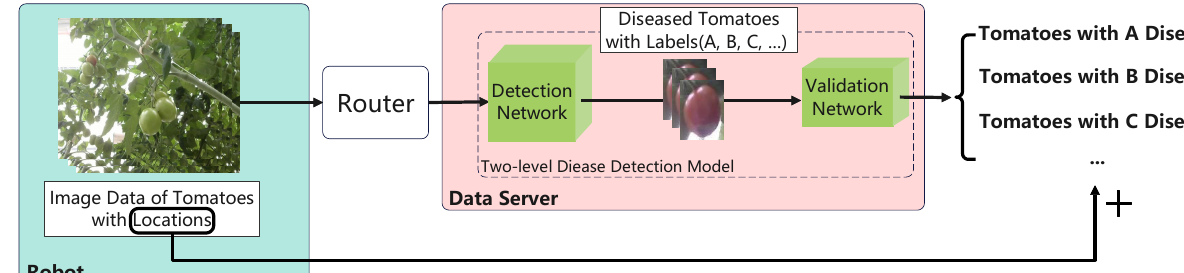
Figure 3. The overview of the tomato disease monitoring